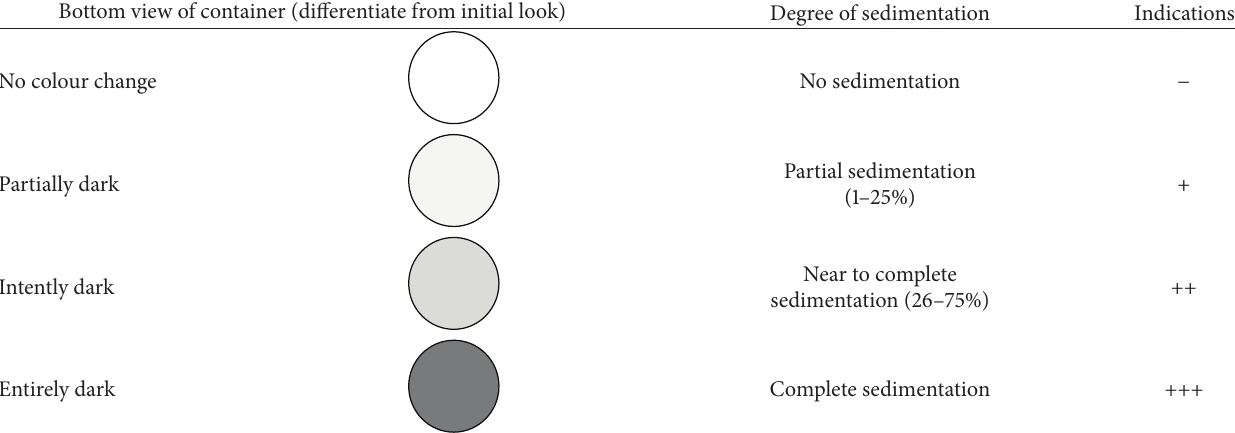
Table 1: Bottom view of container showed different degrees of